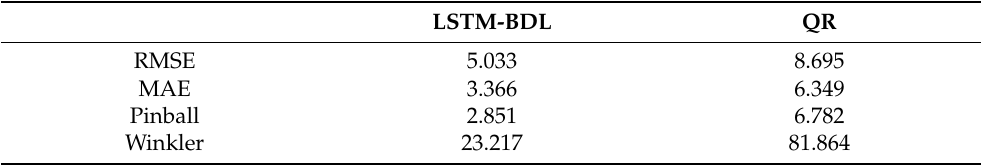
Table 3. Forecasting results for LSTM-BDL and